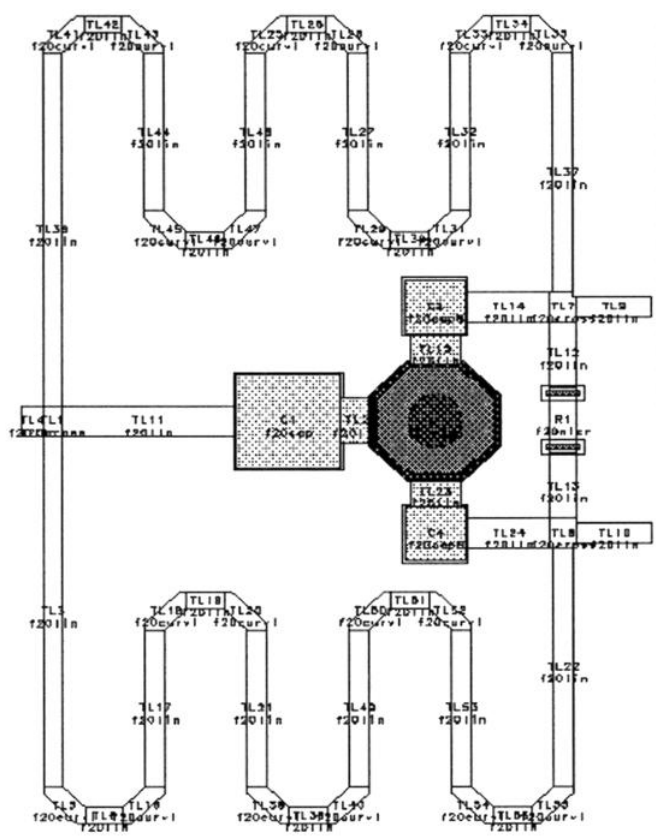
FIGURE 6 Final layout of the Wilkinson